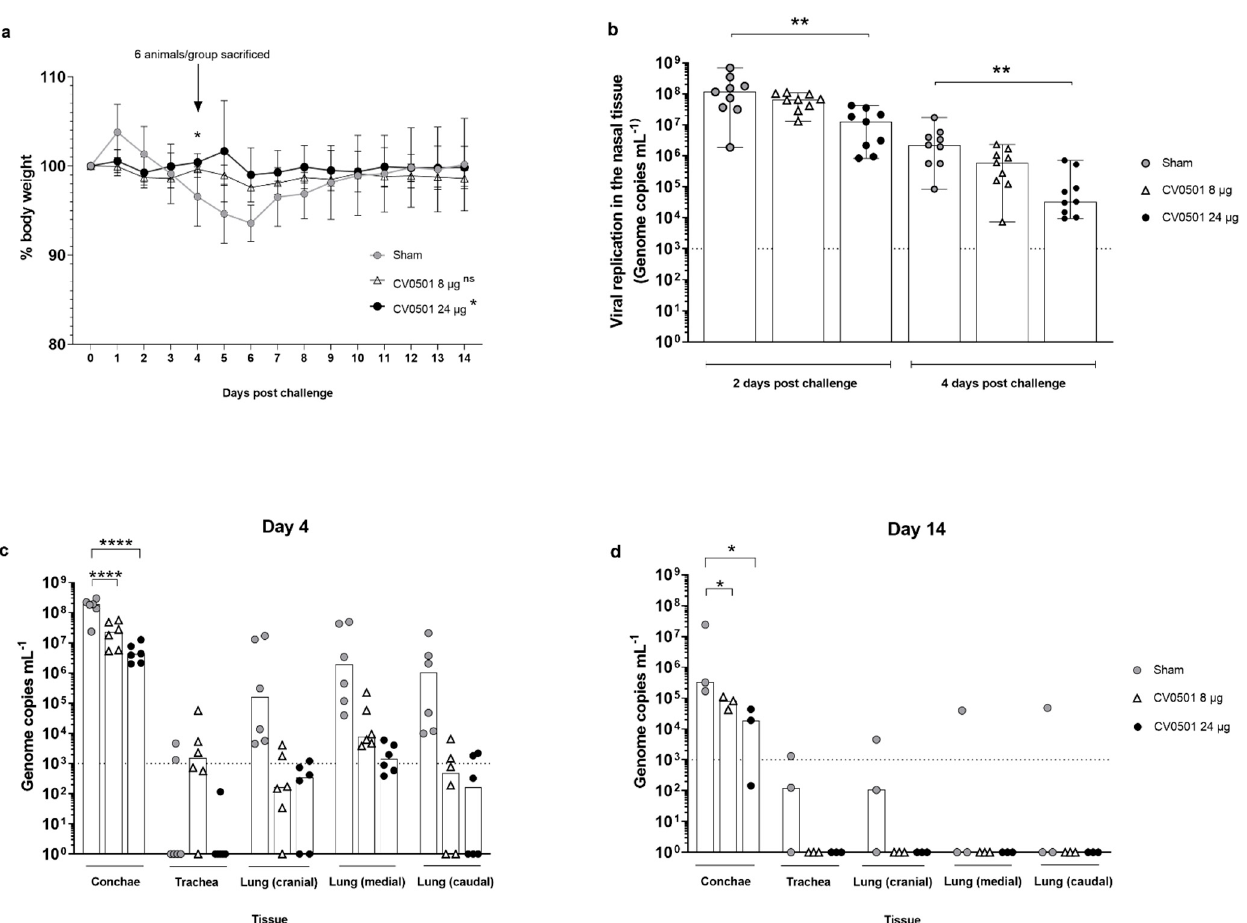
Figure 6. Immunization with CV0501 provided protection against Omicron BA.2 challenge in Syrian hamsters. Male Syrian hamsters ( n = 9/group) received either 8 µg or 24 µg CV0501 or 0.9% NaCl (sham controls) on Days 0 and 28, followed by challenge with Omicron BA.2 (10 5 TCID 50 /animal administered i.n. at 0.05 mL per nostril) on Day 56. ( a ) Percentage body weight was recorded daily between Days 0 and 14 post-challenge. Each dot represents the mean value of the group at the indicated time points. Error bars show the SD in each group. Statistical analyses were performed using Dunnett‘s Test for multiple comparisons. ( b ) Viral replication in the nose was assessed in nasal wash samples collected on Days 2 and 4 post-challenge by RT-qPCR. Each dot represents an individual animal, bars represent the median value of the group at the various time points. Statistical analyses were performed for Days 2 and 4 days post-challenge separately using Kruskal-Wallis test and Dunnett‘s Test for multiple comparisons. The dashed line indicates the lower limit of detection for the assay. ( c , d ) Viral loads were assessed in conchae, trachea and lung (cranial, caudal and medial) samples collected on Day 4 ( c ) or on Day 14 ( d ) post-challenge. Each dot represents an individual animal, bars depict the median value of the group at the various time points. Statistical analysis was performed using two-way ANOVA testing. Samples exhibiting less than 10 3 genome copies per mL (dashed line) were considered negative. * p < 0.05, ** p < 0.01, **** p < 0.0001 .